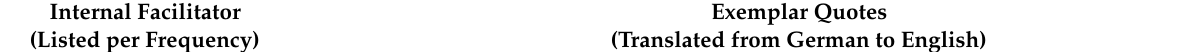
Table 3. Sample narratives by obstetricians expressing their spectrum of internal facilitators when delivering news of fetal